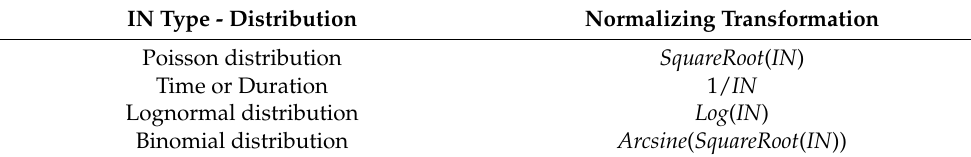
Table 2. Transformation to obtain normally distributed